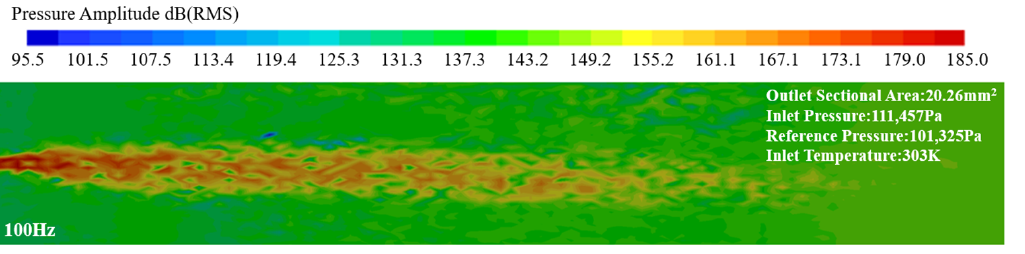
Figure 20. Cloud map of the 100 Hz near-field sound pressure levels of the standard nozzle.